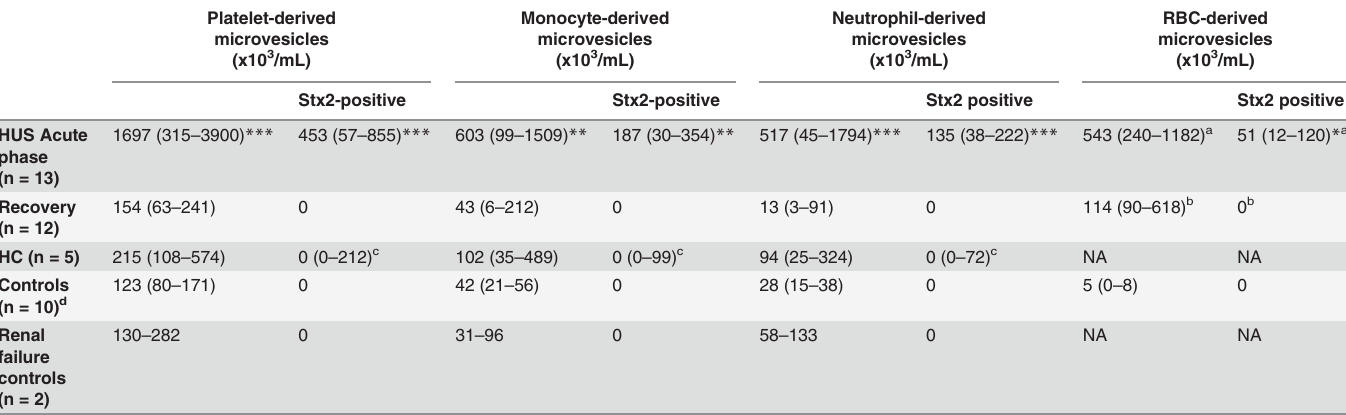
Table 1. Numbers and cellular origin of microvesicles containing Stx2 in plasma from patients and controls.